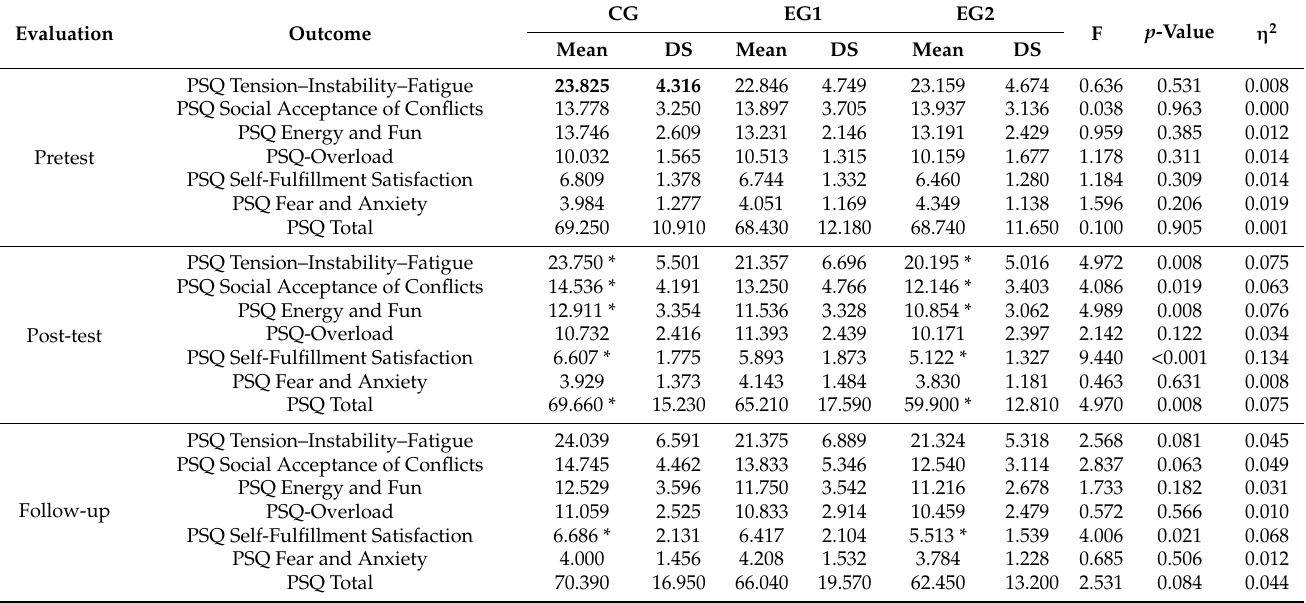
(Table 2). In the post-test inter-group comparisons, significantly lower scores were obtained in the variables PSQ-Tension, PSQ-Social, PSQ-Everyfun, PSQ-Satisfaction, and PSQ total score. Bonferroni pairwise comparisons showed that these differences were established between CG and EG2 (PSQ-Tension, p = 0.008; PSQ-Social, p = 0.016; PSQ-Everyfun, p = 0.008; PSQ-Satisfaction, p <0.001; PSQ total score, p = 0.043). There were no significant differences between the CG and EG1, or between EG1 and EG2. In the follow-up inter- group comparisons, significant scores were only obtained in the PSQ-Satisfaction factor. Bonferroni pairwise comparisons showed that these differences were established between the CG and the EG2 ( p = 0.019). Table 2. Inter-group comparison of PSQ at different evaluation points, using one-way ANOVA. Evaluation